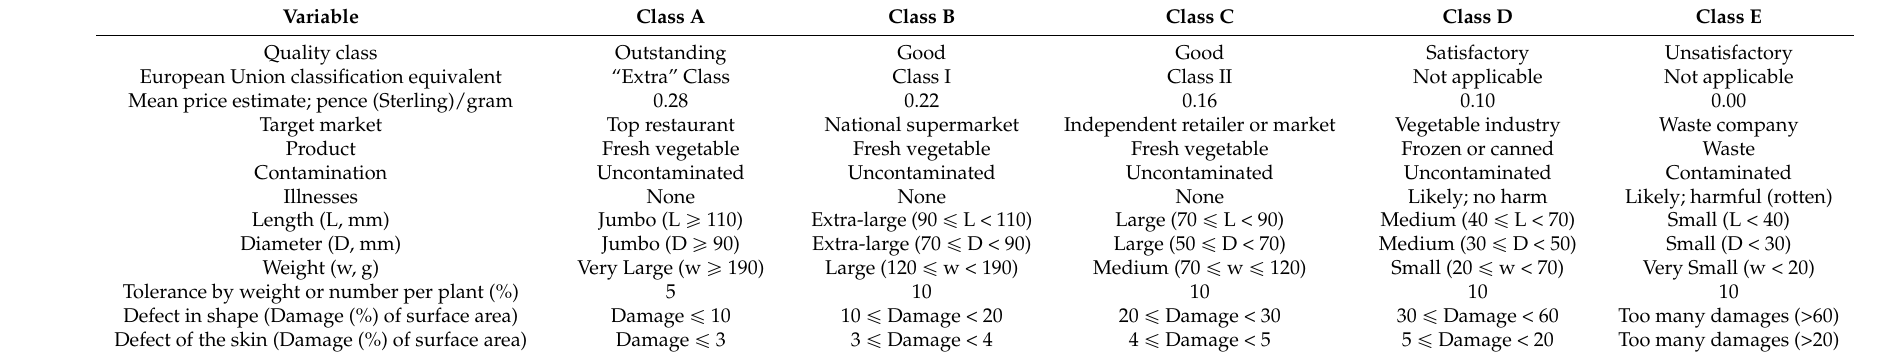
Table 2. Sweet Pepper harvest classification scheme (partly adopted from elsewhere